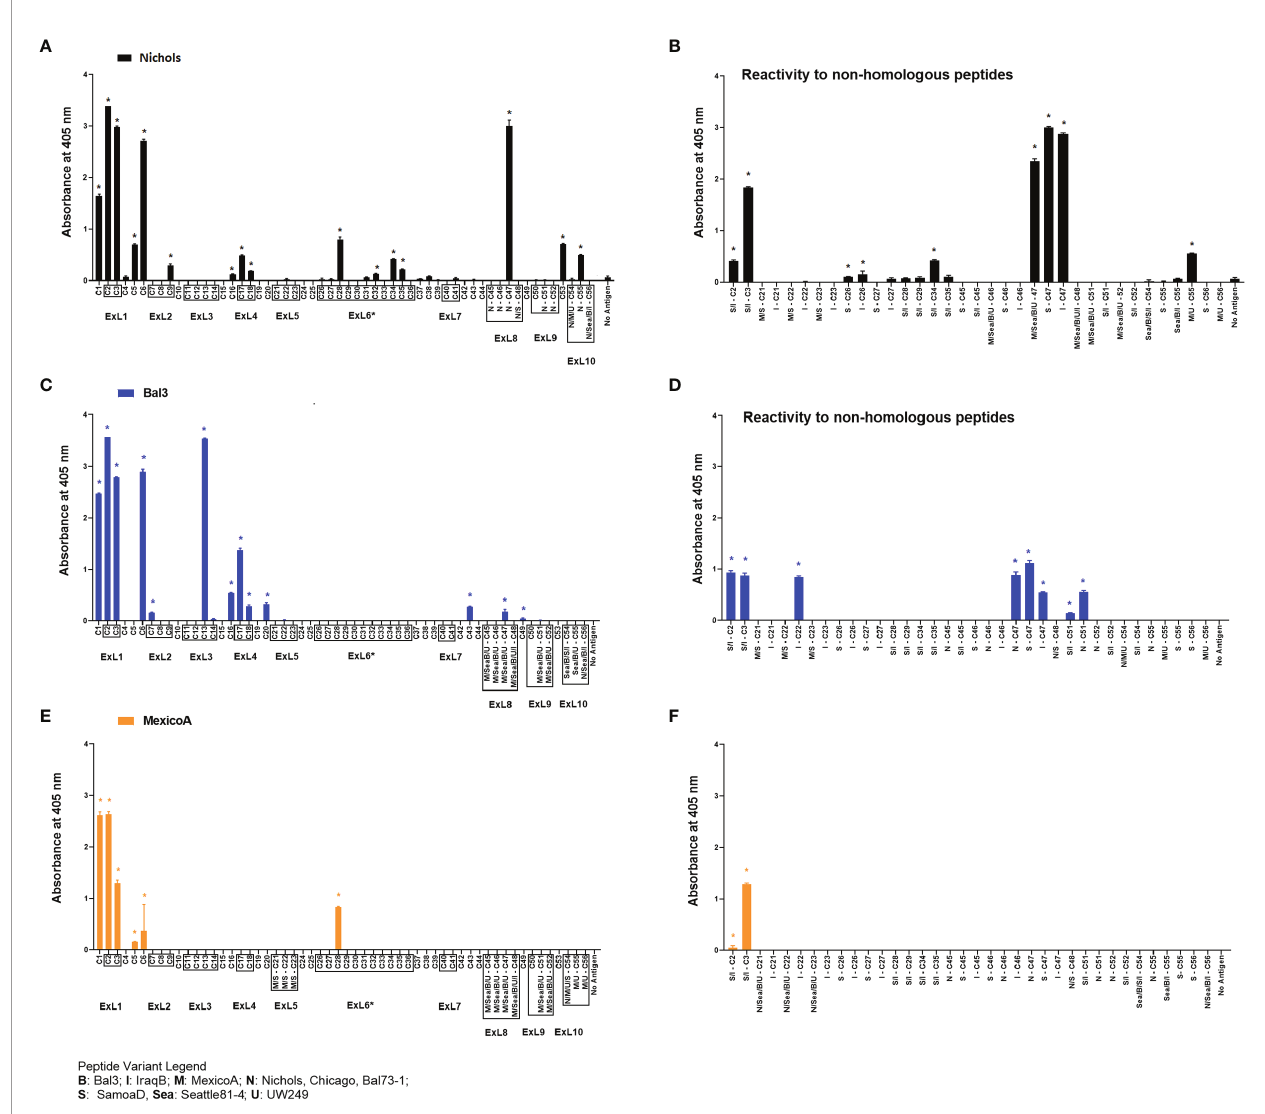
FIGURE 5 | Humoral reactivity to TprC peptides following immunization with refolded recombinant full-length TprC antigens. Reactivity to TprC homologous (left panels) and non-homologous peptides (right panels) in sera from rabbits immunized with Nichols (A, B) , Bal3 (C, D) , and Mexico A (E, F) variants of TprC. Asterisk (*) indicates signi fi cant reactivity compared to no antigen control. Peptides encompassing sequences predicted to be within ExLs are boxed. Peptide sequence and homology among strains are reported in Table S6 . Strain names on x axes are abbreviated as follows: N, Nichols; M, MexicoA; Sea, Sea81-4; B, Bal3; U, UW249; S, SamoaD; I,